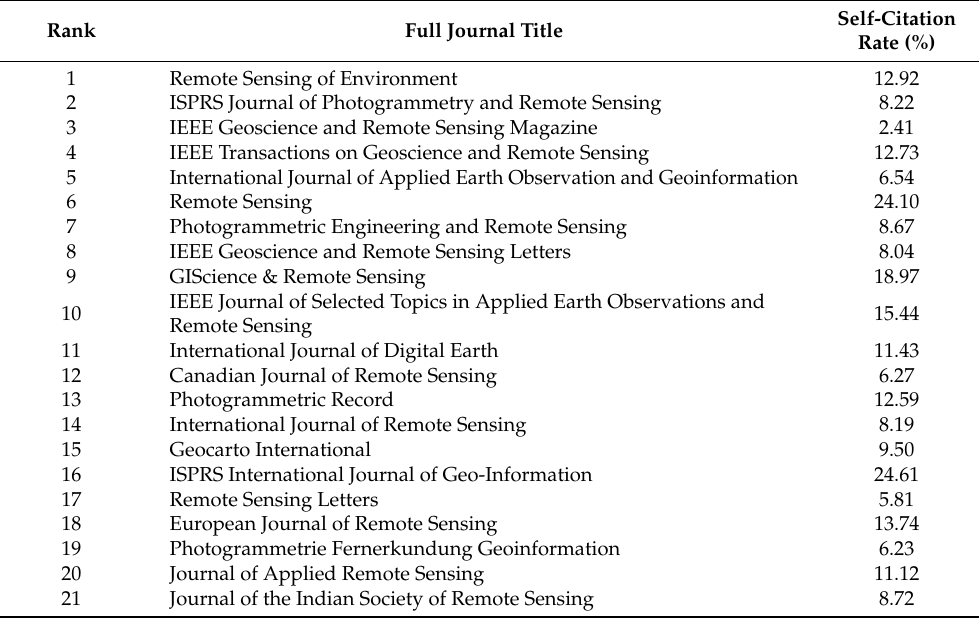
Table 14. Comparison of various remote sensing journals about self-citation rate (%).